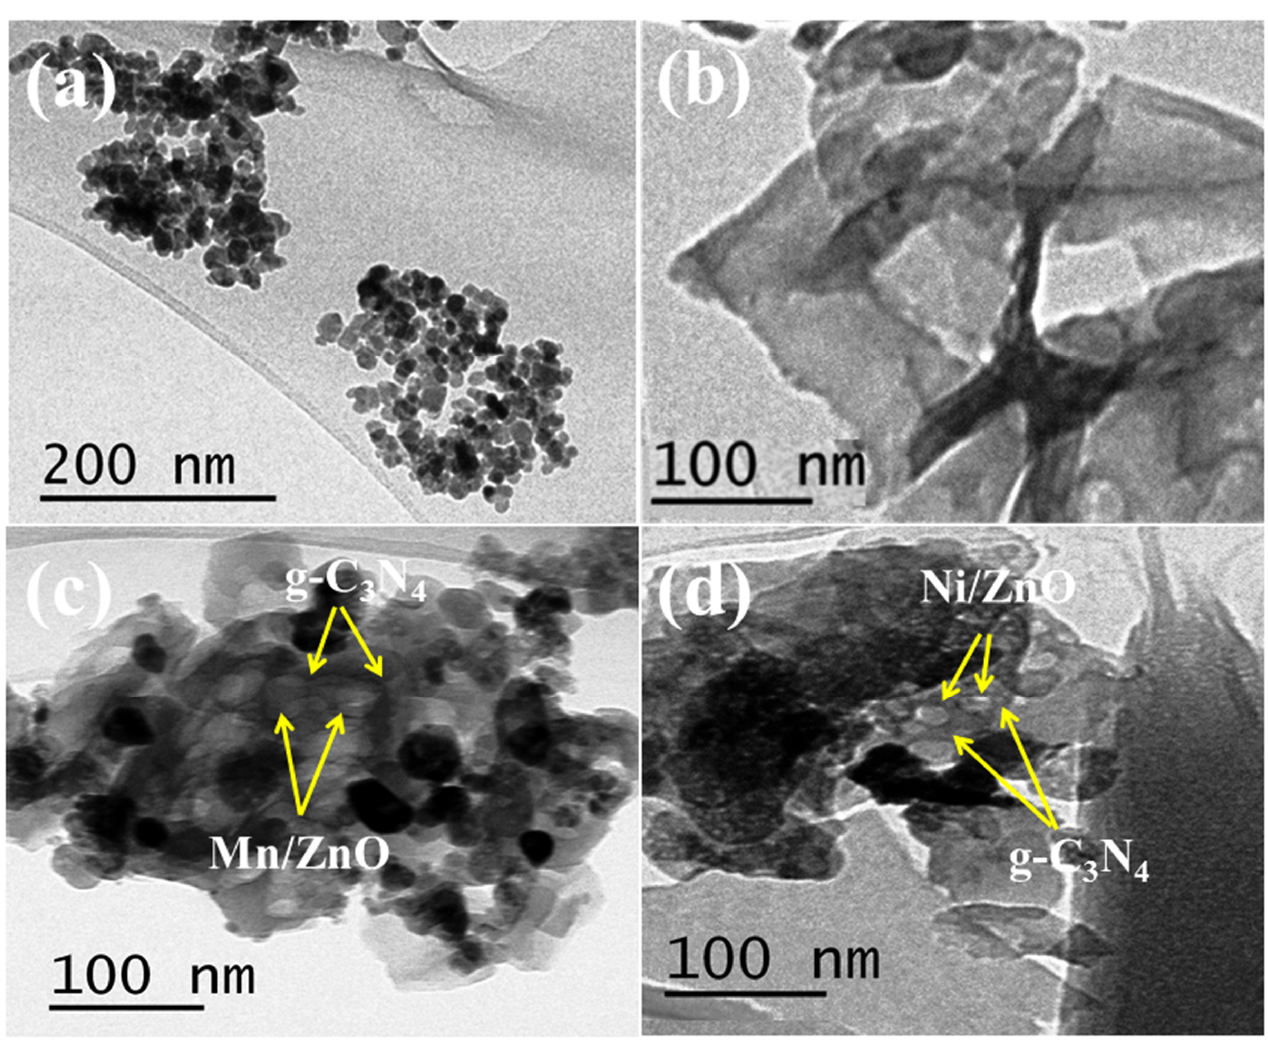
Figure 4. Morphological analysis of ZnO ( a ), g-C 3 N 4 ( b ), Ni/g-C 3 N 4 /ZnO ( c ), and Mn/g-C 3 N 4 /ZnO ( d ) by TEM.